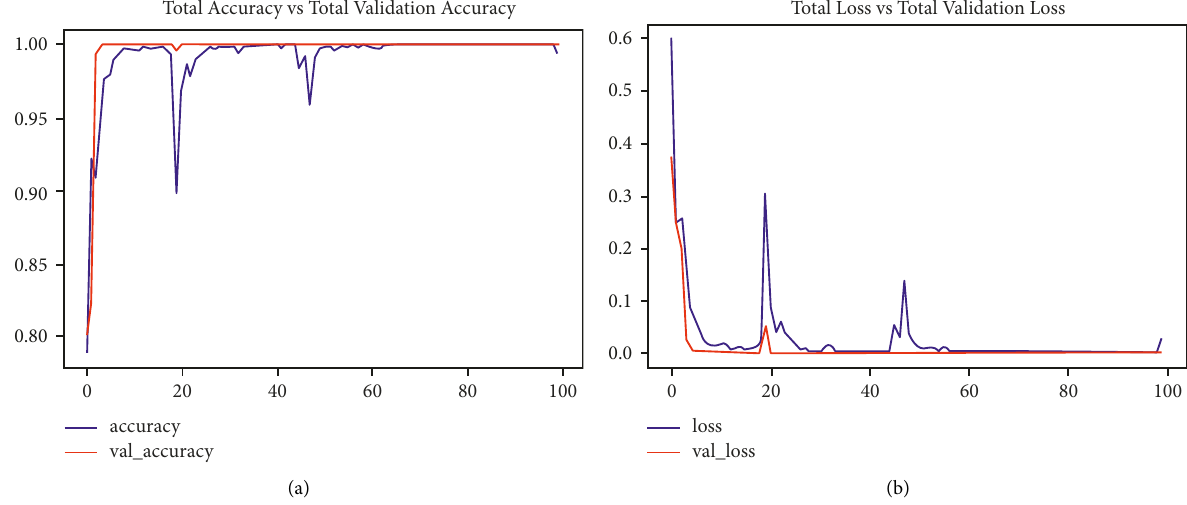
Figure 6: Performance measures of training and testing datasets: (a) accuracies and (b) loss.